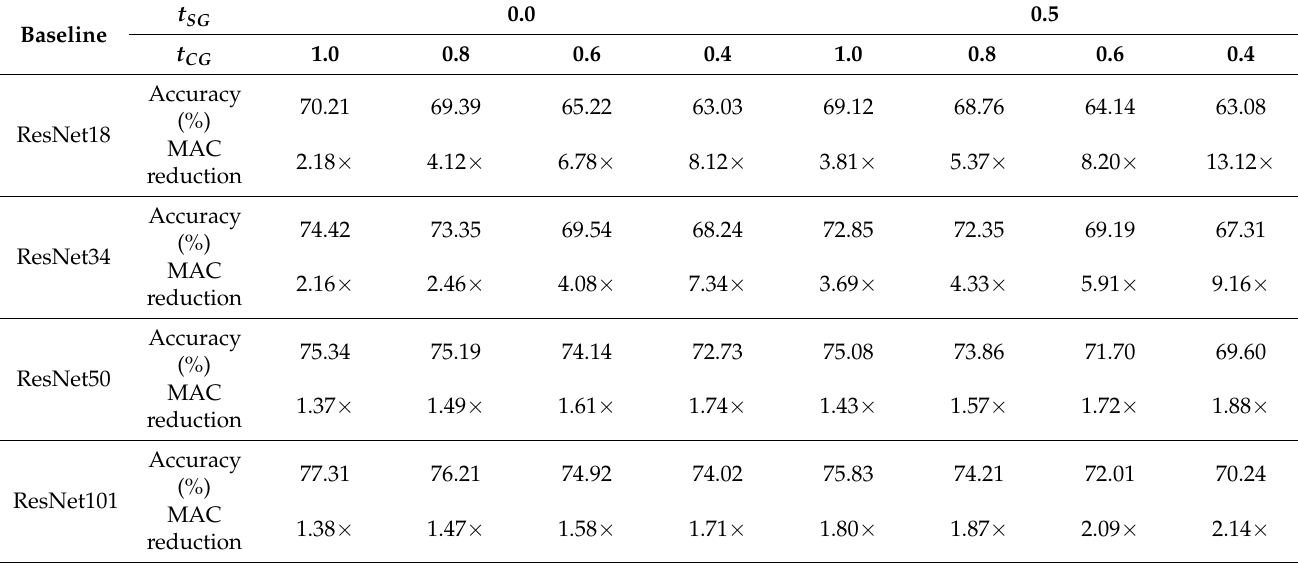
Table 4. Top-1 accuracy and the MAC reduction of the CSGN on ImageNet.